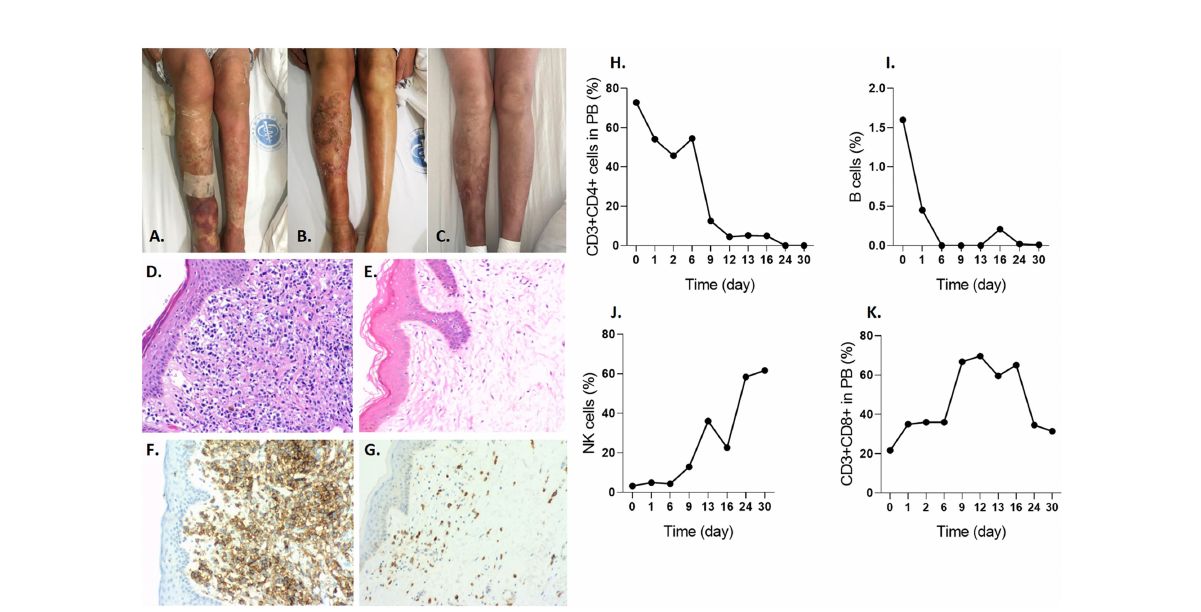
FIGURE 5 CD4-IL15/IL15sushi CAR T cells improve symptoms in Patient 2 with mycosis fungoides lymphoma. (A) Leg skin appearance with erythema and swelling before treatment with CD4-IL15/IL15sushi CAR T cells. (B) Leg skin appearance 2 weeks after treatment shows some improvement. (C) Leg skin appearance after 4 weeks after treatment show even further improvement. (D) H&E staining of skin biopsy before treatment show numerous lymphocytic in fi ltrates. (E) H&E staining of skin biopsy days after infusion of CD4-IL15/IL15sushi CAR T cells show less lymphocytic cells in the skin. (F) CD4 expression of malignant T cells in skin biopsy before treatment. (G) Diminished CD4 expression in skin biopsy days after infusion. (H) CD3+CD4+, including the malignant cells, reduced to undetectable levels by 24 days after CD4-IL15/IL15sushi CAR T cell therapy. (I) Therapy led to rapid suppression of B cells to undetectable levels by 6 days after treatment. (J) Expansion of NK cells 1 month after therapy. (K) Expansion of CD3+CD8+ cells in the fi rst month